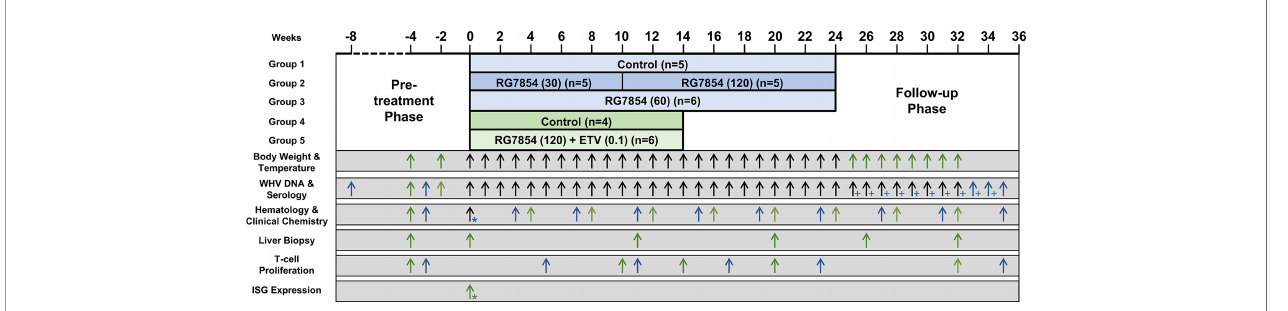
FIGURE 1 | Study design. In the monotreatment study ( ▀ ), woodchucks were dosed with vehicle or RG7854 (30/120 or 60 mg/kg orally, QOD) for 24 weeks and followed for another 11 weeks. Starting in week 10 of treatment, the 30 mg/kg dose was increased to 120 mg/kg in Group 2 and administered for 14 weeks. In the combination treatment study ( ▀ ), woodchucks were dosed with vehicle or RG7854 (120 mg/kg orally, QOD) together with ETV (0.1 mg/kg orally, once daily) for 14 weeks and followed for another 18 weeks. Arrows indicate the time of measurements for the speci fi c parameters listed. Black arrows indicate parameters measured in both studies. * Pre-and post-dose samples were collected. + Only serum WHV DNA was